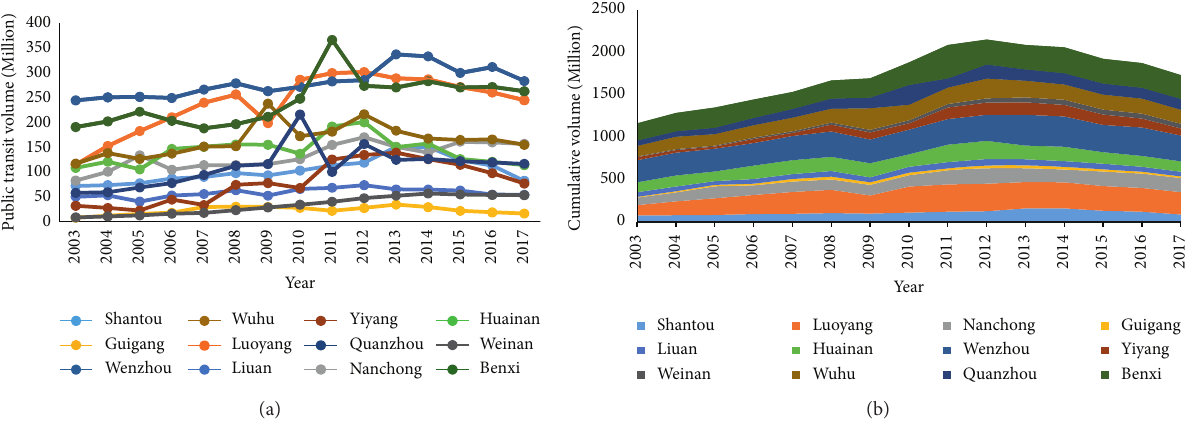
Figure 2: The passenger volume of public transport in small-medium cities. (a) Passenger volume, (b) cumulative passenger